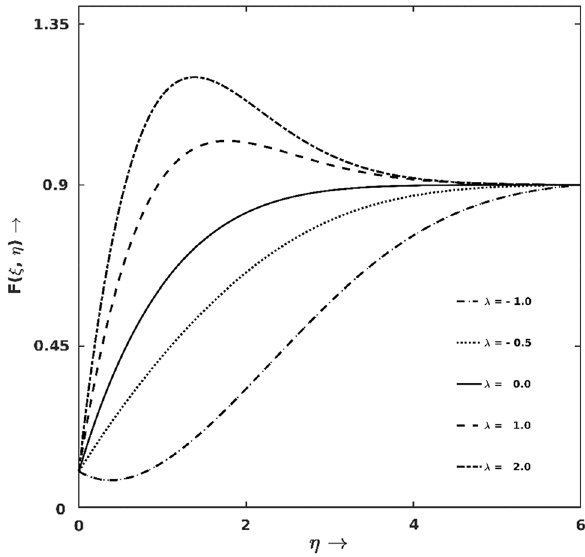
Figure 2. (cid:31) effect on F .